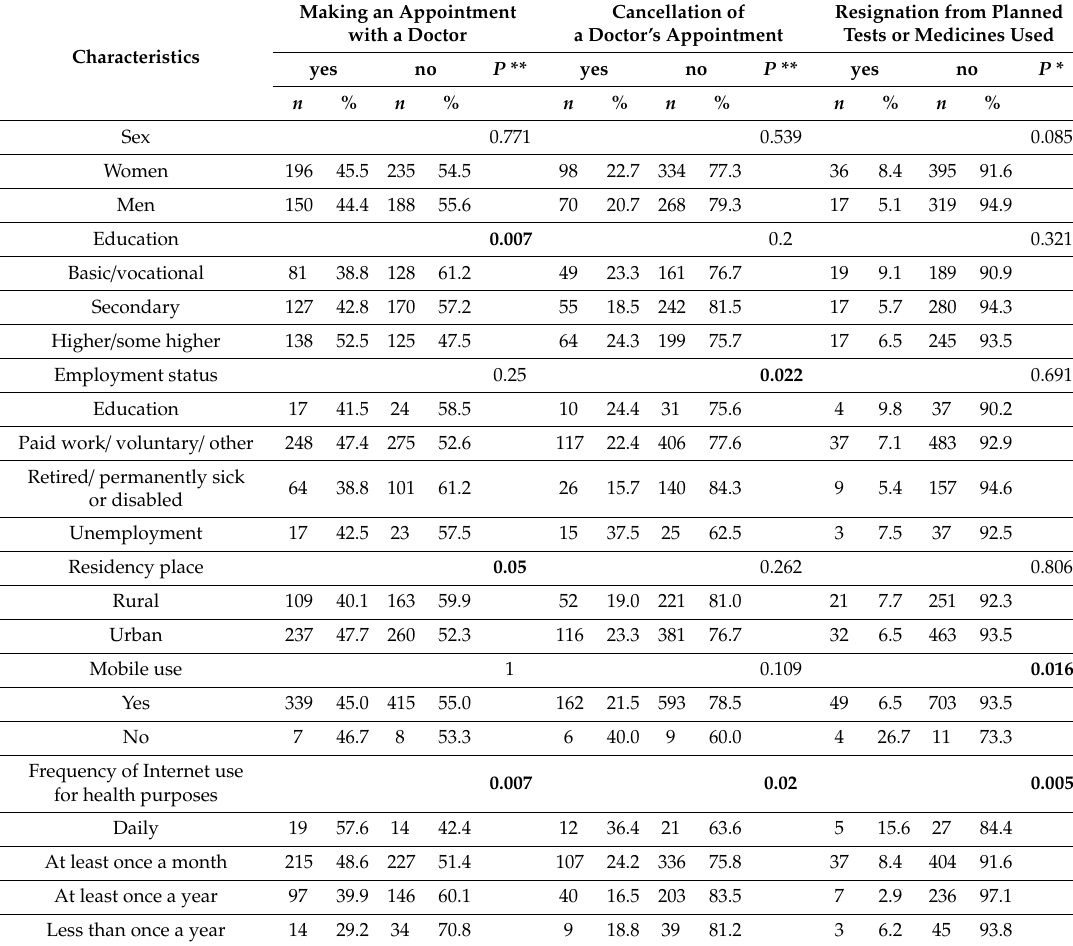
Table 6. Self-reported health decisions triggered by health or disease information obtained from the